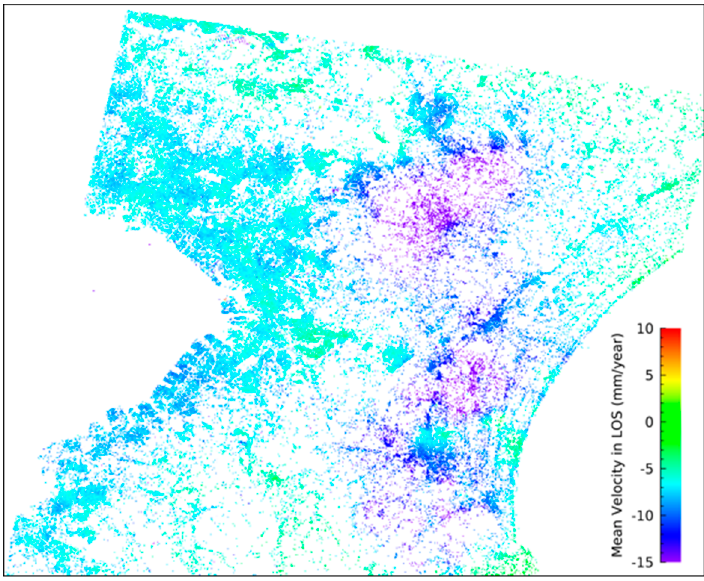
Figure 9. Corrected mean displacement velocity from 2015 to 2019, derived from the PALSAR ‐ 2 data.